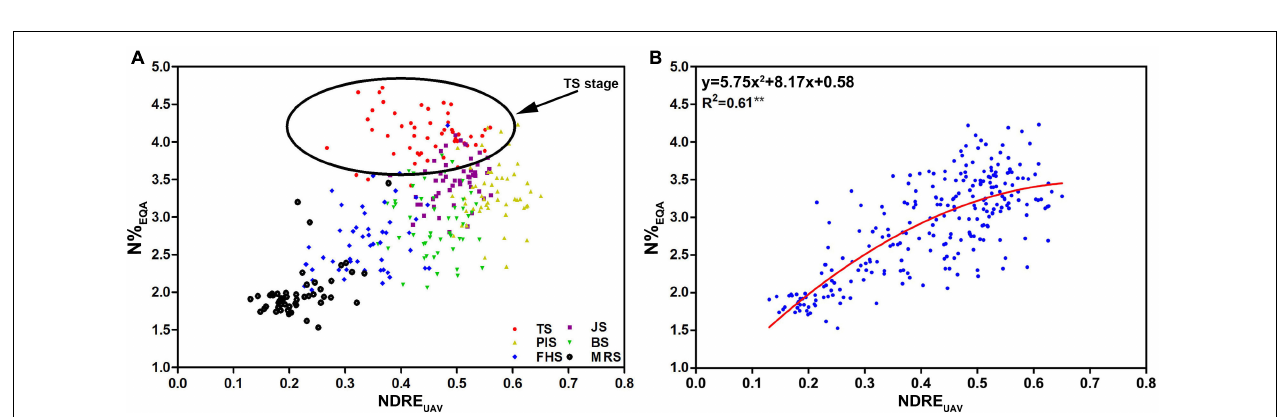
FIGURE 6 | The data plots and regression Model I constructed from 51 rice varieties were based on the UAV-RSP for the six developmental stages. (A) Relationship between N% EQA and NDRE UAV ( n = 306): TS (red); JS (purple); PIS (yellow); BS (green); FHS (blue), and MRS (black); (B) regression model of N% EQA and NDRE UAV for the five stages ( R 2 = 0.61, n = 255; ** P < 0.01). The circle in (A) highlights the data points of